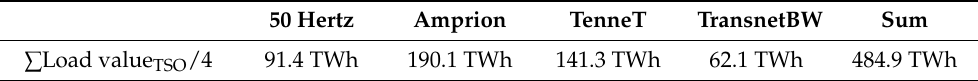
Table 5. Aggregated load of each TSO for 2010 per